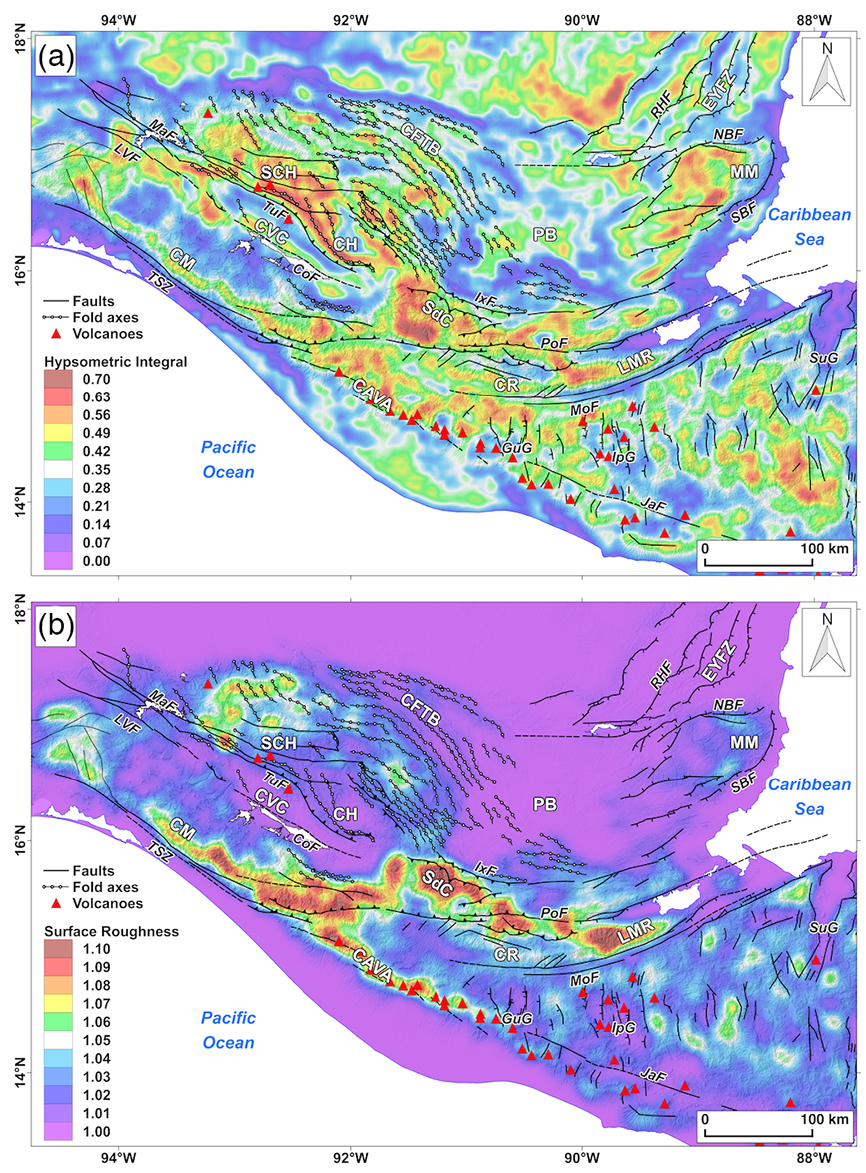
Figure 7. Hypsometric integral (a) and surface roughness (b) for northern Central America. See Fig. 2 for